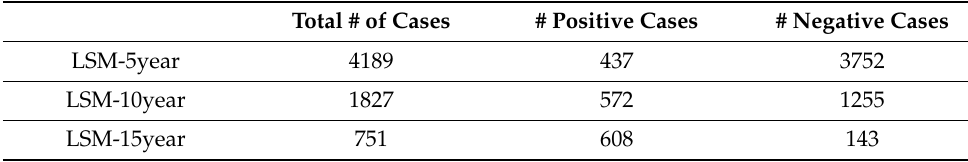
Table 1. Case counts of the LSM datasets (#: